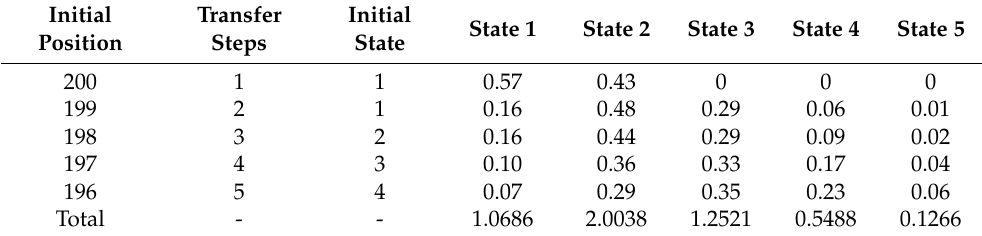
Table 10. State prediction of residual relative value by the grey Markov model.